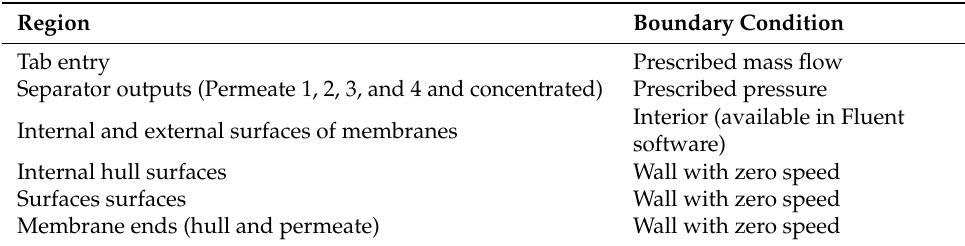
Table 2. Boundary conditions used in the simulations.